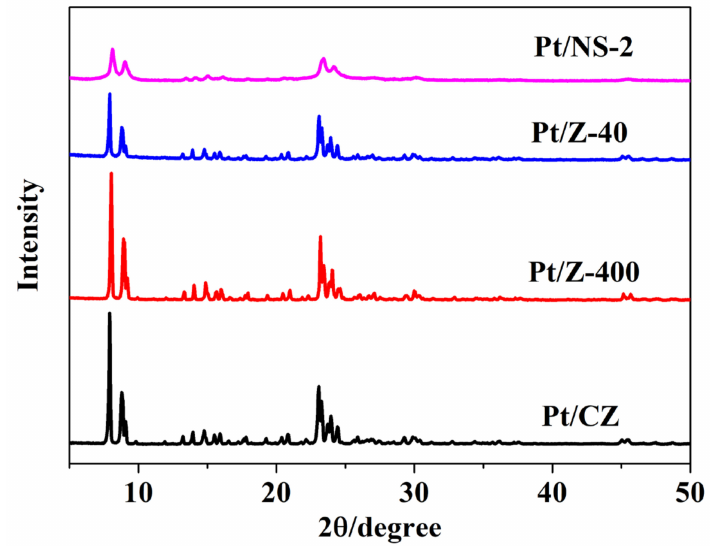
Figure 3. XRD patterns of the prepared Pt-loaded